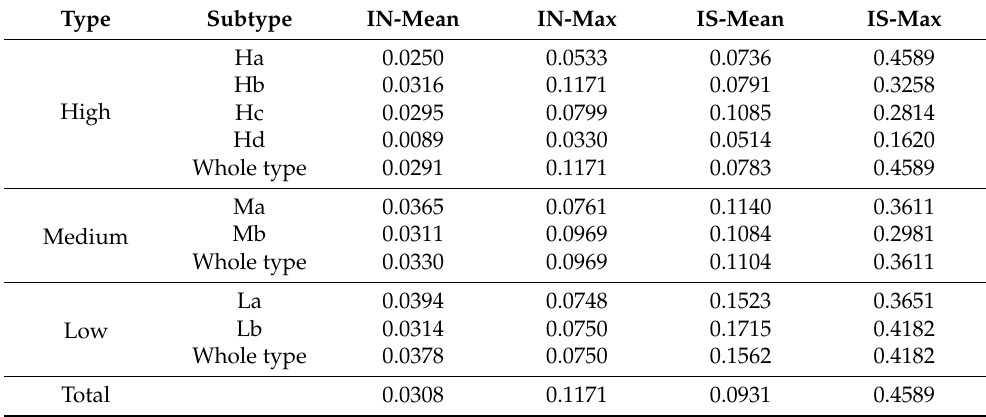
Table 5. Changeability of values of inhomogeneity (IN) and isolation (IS) indices in relief types and